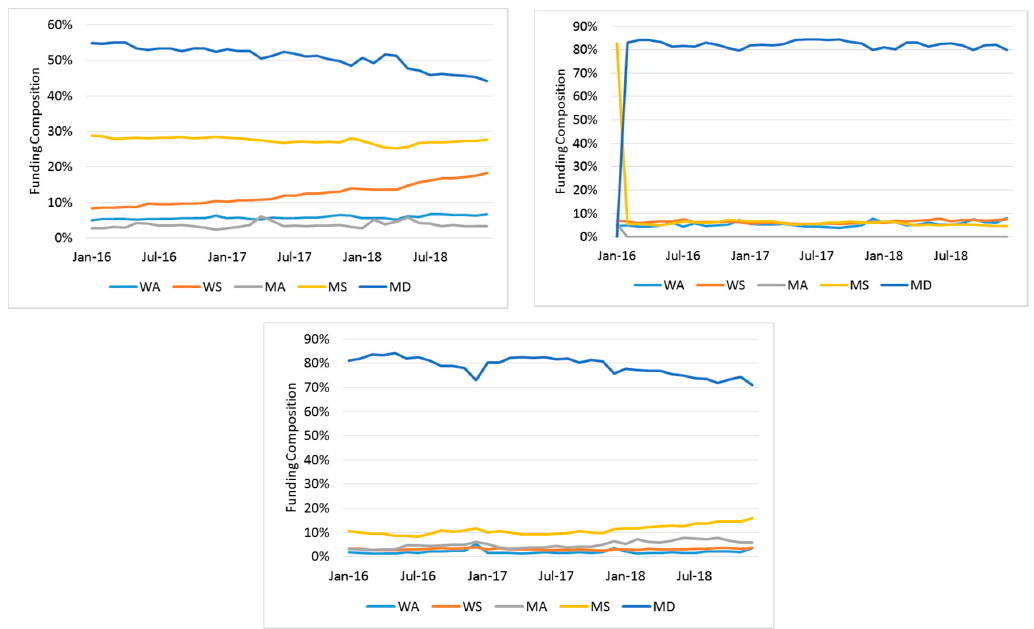
Figure 2. Compositions of funding fund from Bank A ( top left ), B ( top right ) and C ( bottom ).